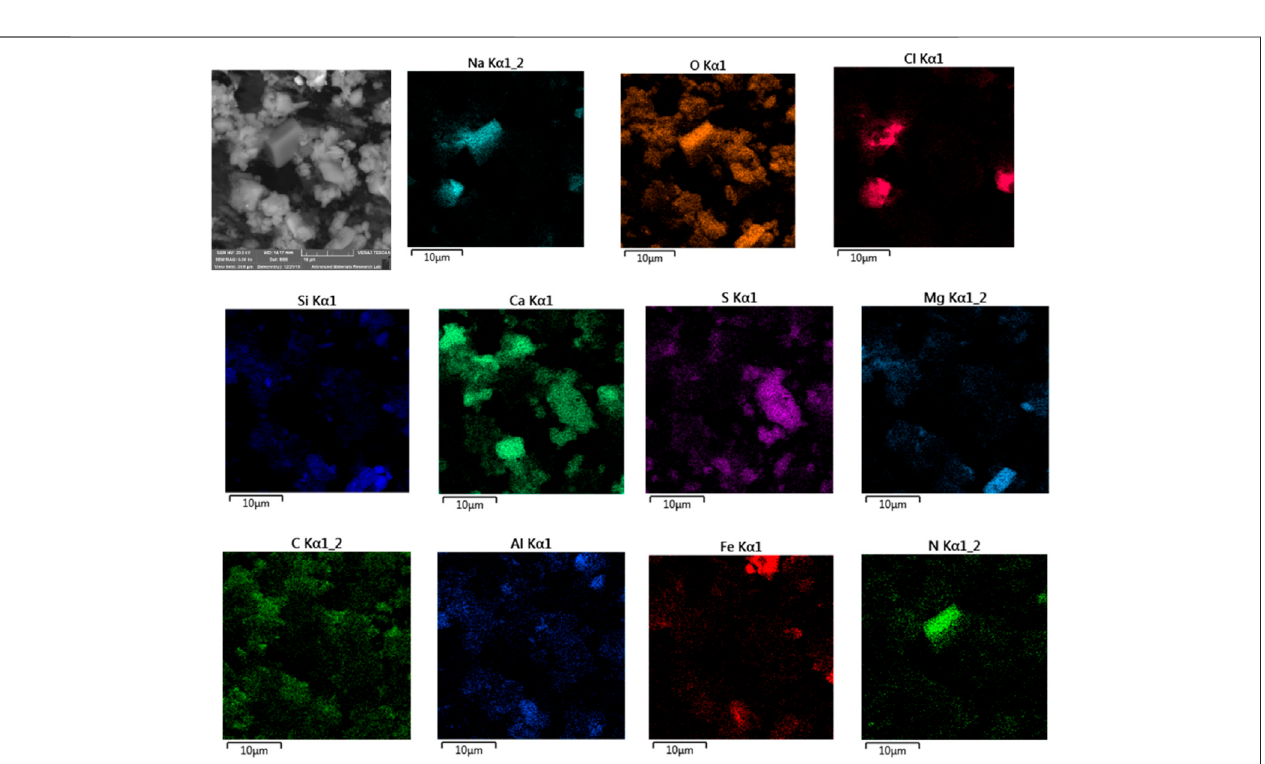
FIGURE 7 | SEM micrograph and EDS elemental maps for sample